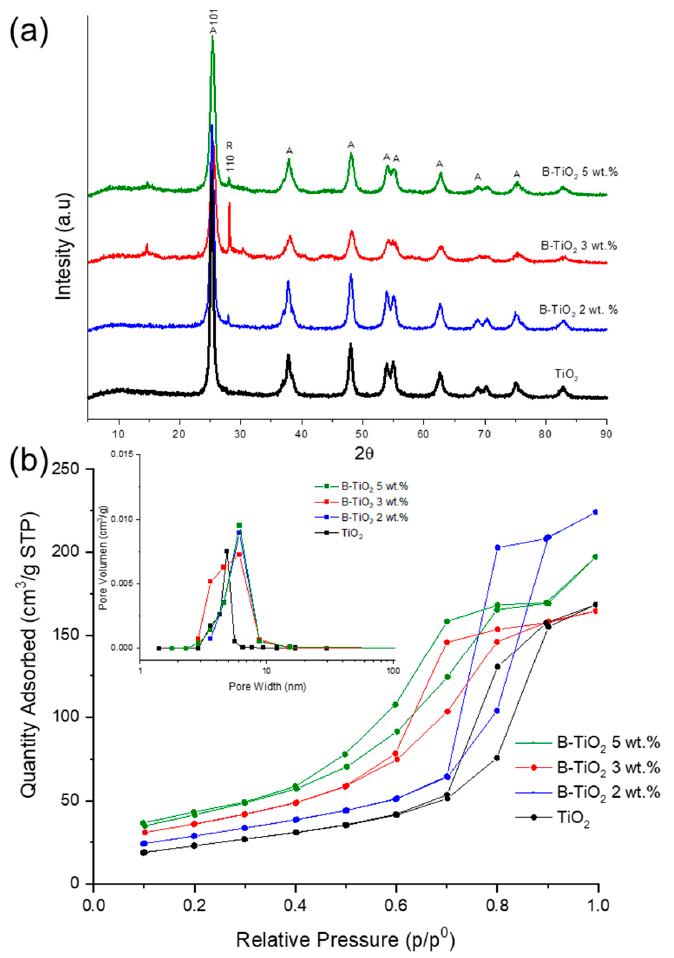
Figure 1. XRD patterns and ( a ) N 2 adsorption–desorption isotherms of ( b ) Boron-doped and non- doped TiO 2 photocatalysts.